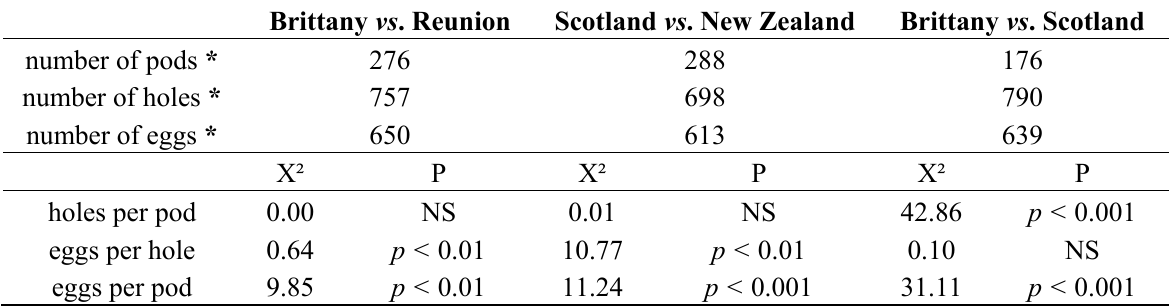
Table 1. Results of the X 2 tests for oviposition choice by Exapion ulicis on Ulex europaeus pods. Brittany vs . Reunion Scotland vs . New Zealand Brittany vs . Scotland number of pods * 276 288 176 number of holes * 757 698 790